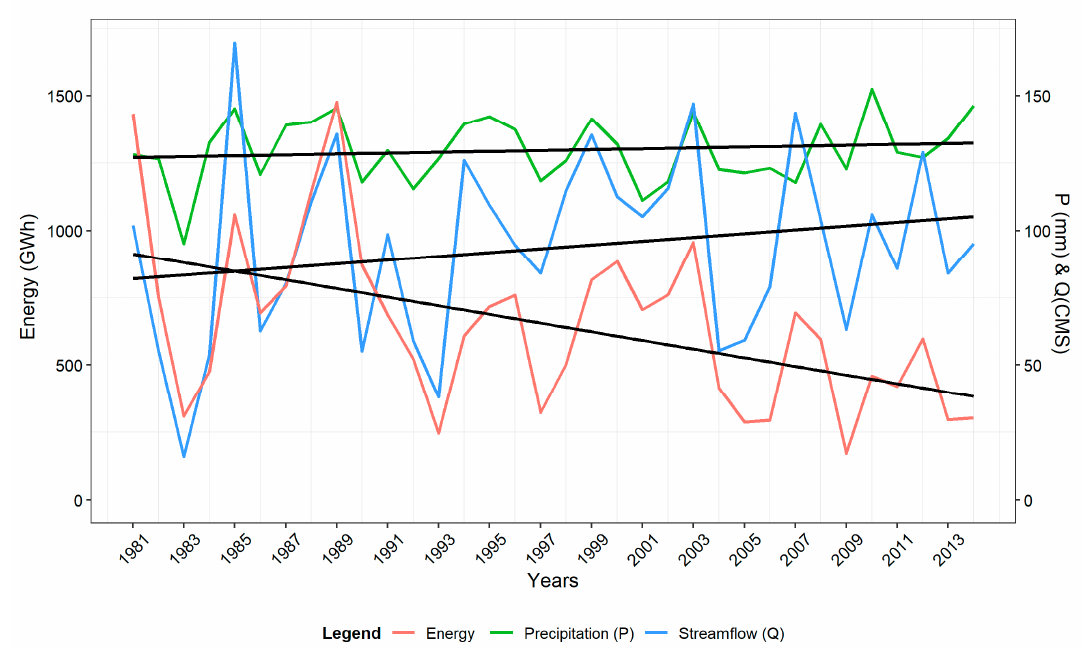
Figure 4. Annual variability: total hydropower generation (GWh in red color); mean annual GPCP precipitation (P in mm in green color) and mean annual streamflow (Q in m 3 / s in blue color). The black line is the regression line for each variable.